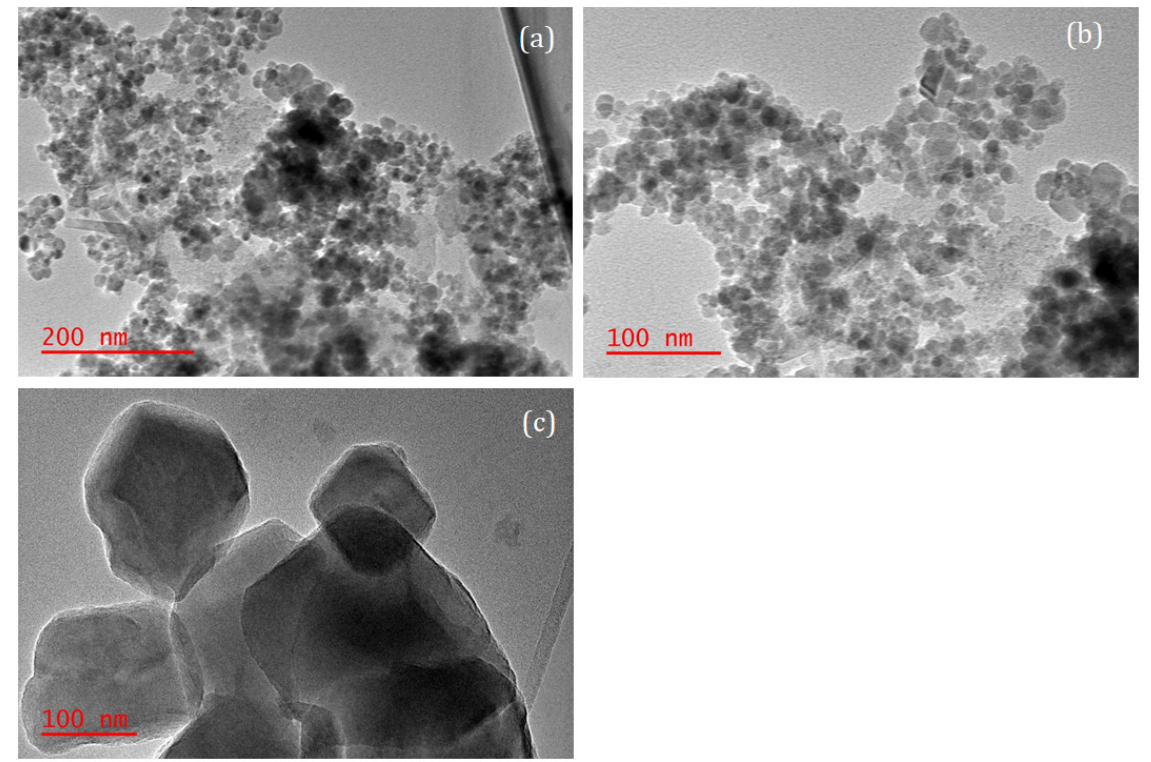
Figure 5. TEM images of AC-Fe 3 O 4 ( a ), AC-Fe 3 O 4 -SiO 2 ( b ), and AC-Fe 3 O 4 -SiO 2 -PEI ( c ). Thermogravimetric analysis (TGA) and derivative thermogravimetric analysis (DTA) were used to study the thermal stability and decomposition stages of AC-Fe 3 O 4 , AC-Fe 3 O 4 -SiO 2, and AC-Fe 3 O 4 -SiO 2 -PEI. The results are demonstrated in Figure 6. The decomposition curves exhibit different patterns as distinctly shown by the derivatives curves. However, some commonalities were observed, such as the decomposition stage taking place between 40 and 100 ◦ C credited to moisture loss. This was quantified to 5, 5, and 10% weight loss for AC-Fe 3 O 4 , AC-Fe 3 O 4 -SiO 2, and AC-Fe 3 O 4 -SiO 2 -PEI, respectively. The second weight loss was observed between 100 and 800 ◦ C with 5% weight loss for AC-Fe 3 O 4 , between 100 and 300 ◦ C for AC-Fe 3 O 4 -SiO 2 with 15% weight loss, and lastly between 300 and 600 ◦ C for AC-Fe 3 O 4 -SiO 2 -PEI with 40% weight loss. This stage was attributed to the loss of volatile compounds such as CO 2, CH 4 , CO, and decomposition of adsorbents [36]. More of this weight loss was expressed with AC-Fe 3 O 4 -SiO 2 and AC-Fe 3 O 4 -SiO 2 -PEI as compared to AC-Fe 3 O 4 . This was attributed to longer chains of CH 3 CH 2 - of the TEOS and those of the branched PEI. The last decomposition stage was attributed to the loss of lignin of the adsorbent which was more pronounced with AC-Fe 3 O 4 -SiO 2 and AC-Fe 3 O 4 -SiO 2 -PEI than with AC-Fe 3 O 4 . Less weight loss observed by AC-Fe 3 O 4 was attributed to the thermal stability of the Fe 3 O 4 nanoparticles.